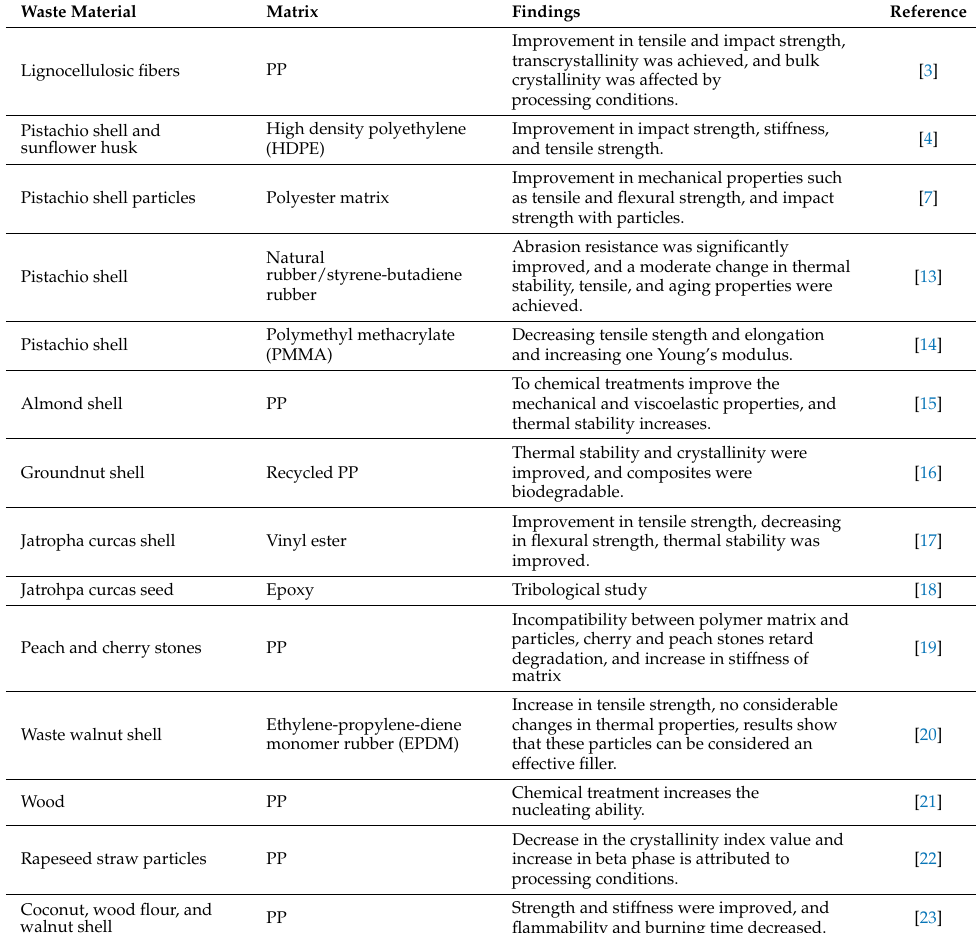
Table 1. Different types of waste materials used in polymer matrix as